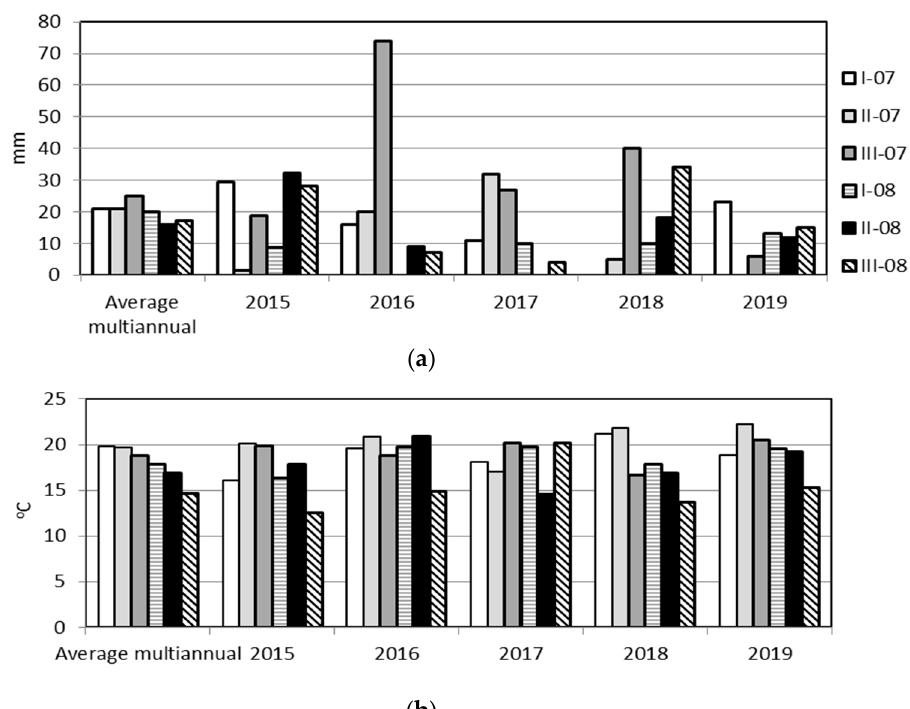
Figure 1. Weather conditions in the southern forest-steppe of Western Siberia: ( a )—precipitation; ( b )—average ten-days temperature; I, II, III—ten-days; 7 July, 8 August (Omsk. July–August 2015–2019).